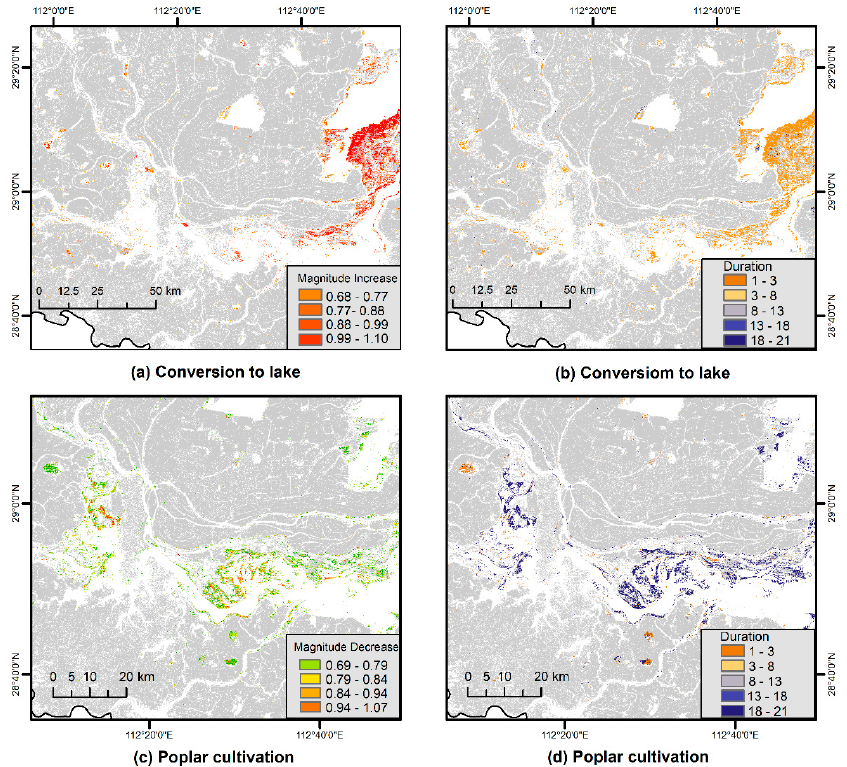
Figure 8. Magnitude and duration of conversion from cropland to ( a,b ) lake and ( c,d ) poplar cultivation in the Dongting Lake region. Close up looks for the prevalent regions of two patterns are displayed.